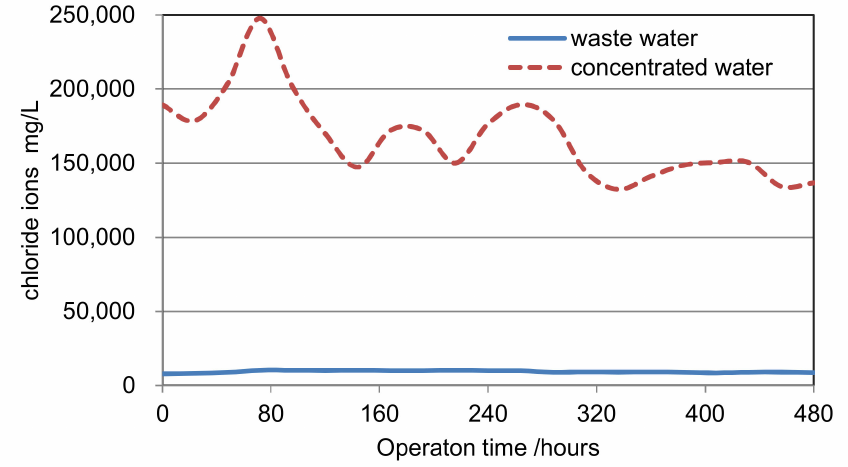
Figure 3. Variation of chloride ions in the slurry for 12-day